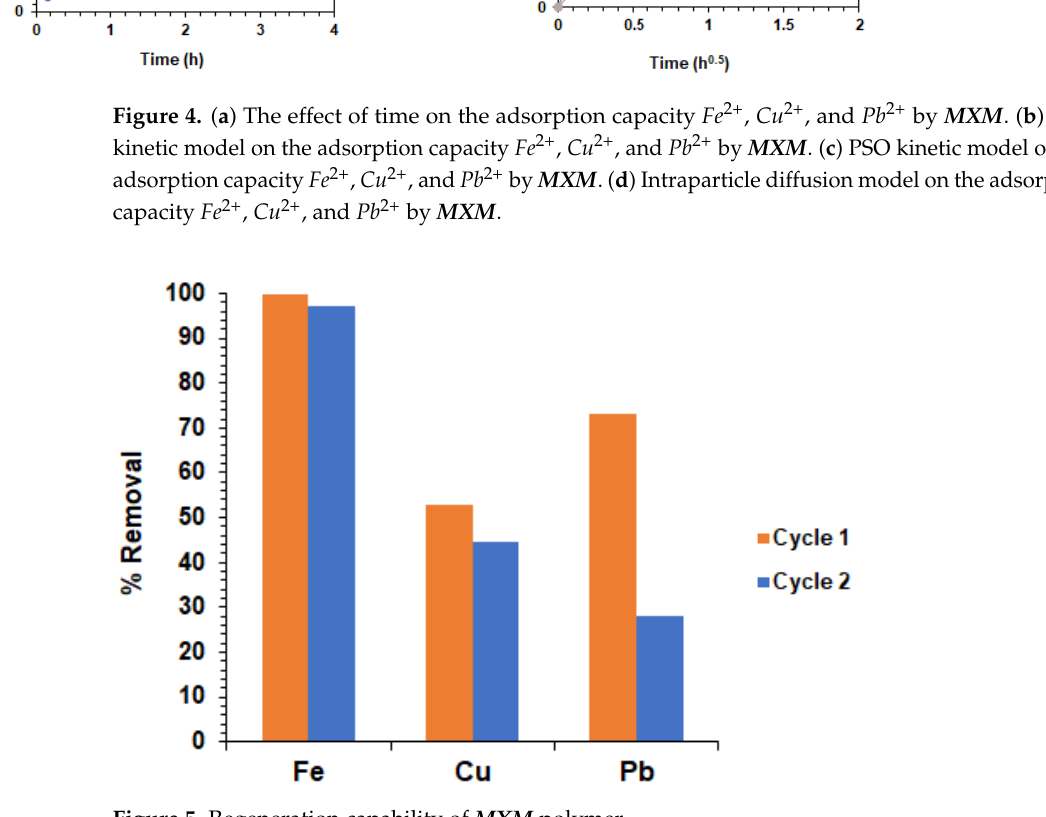
Figure 6. Energy-minimized amorphous cell comprising MXM.